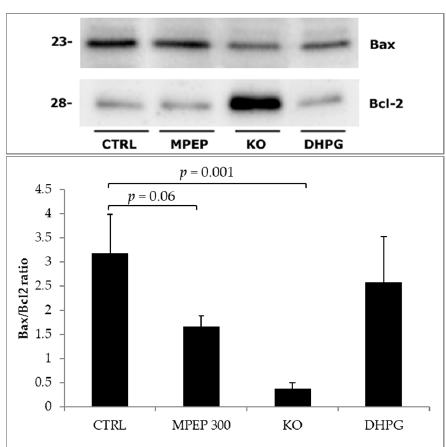
Figure 7. Tissue hepatic Bax/Bcl-2 ratio was significantly reduced in livers from mGluR5 KO mice (Tukey’s Test) after 18 h preservation by cold storage and 60 ′ warm reperfusion. Livers treated with MPEP during preservation and reperfusion had a near-significant reduction of Bax/Bcl-2 ratio, at the end of 60 ′ reperfusion.